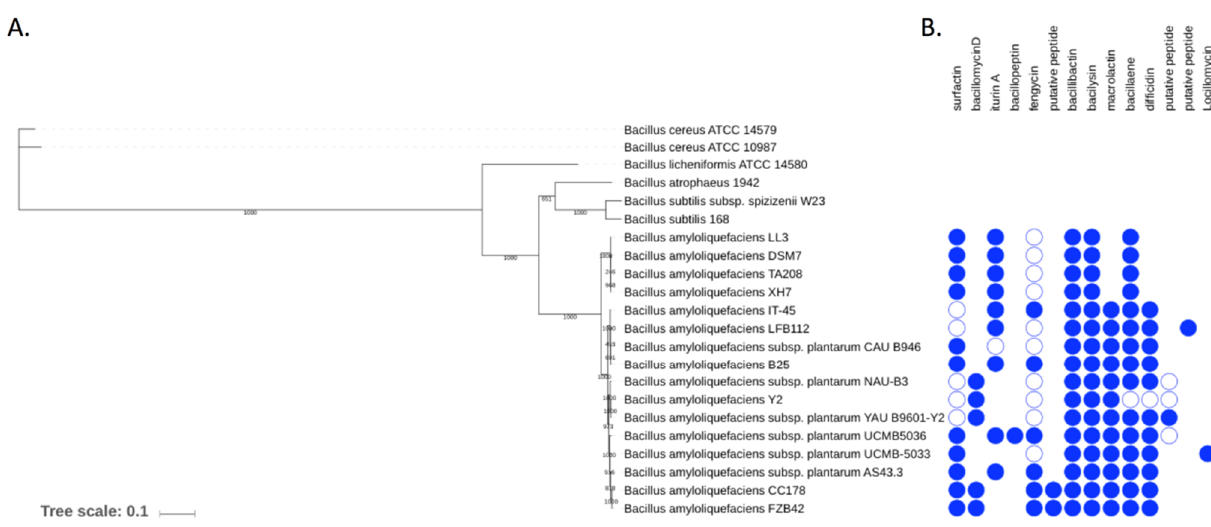
Figure 2. Distribution of NRPS/PKS gene clusters in Bacillus amyloliquefaciens strains in relation to their phylogeny. ( A ) Position of B. velezensis B25 in relation to other species within the genus Bacillus . The species tree was generated by a concatenation of nine conserved proteins using a Maximum Likelihood method for 22 genomes. Bootstrap values above 80% are indicated by black dots. ( B ) Pattern of presence/absence of NRPS/PKS gene clusters for 16 B. amyloliquefaciens strains. The presence of a gene cluster for a given compound is indicated by a circle shape, which is filled in blue when the cluster is complete or empty when the cluster is partial.